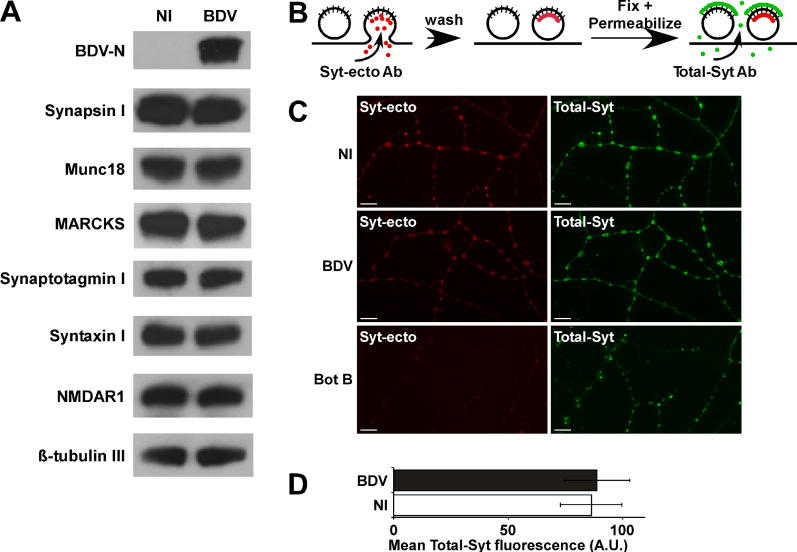
Synapse Integrity Is Preserved in Neurons Persistently Infected with BDV(A) Western blots of neuronal extracts. Comparative analysis of the expression levels of a panel of neuronal proteins from non-infected (NI) and BDV-infected cultures. Results are representative of three independent experiments.(B) Outline of the experimental protocol to measure vesicular cycling at synapses. In a first step, recycling vesicles are labeled with a mouse monoclonal antibody directed against the luminal domain of synaptotagmin 1 (Syt-ecto). After washes, neurons are fixed and permeabilized and incubated with a rabbit antibody directed against the cytoplasmic domain of synaptotagmin 1 (Total-Syt).(C) Examples of Syt-ecto and total-Syt labeling. Bottom panels show neurons treated with botulinum B toxin (Bot B). Bar: 20 μm.(D) Quantification of total-Syt fluorescence staining (n = 381 and 386 synapses for BDV-infected and NI neurons, respectively).